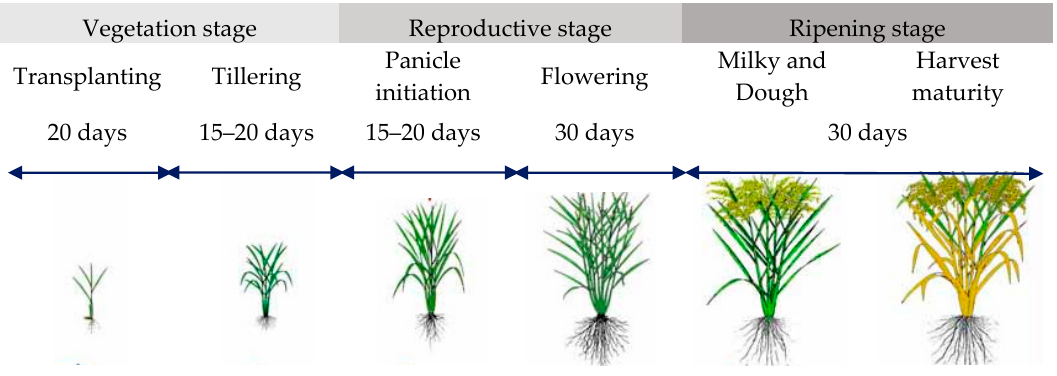
Figure 3. Growth stages of a rice plant (modified from [7,64]).